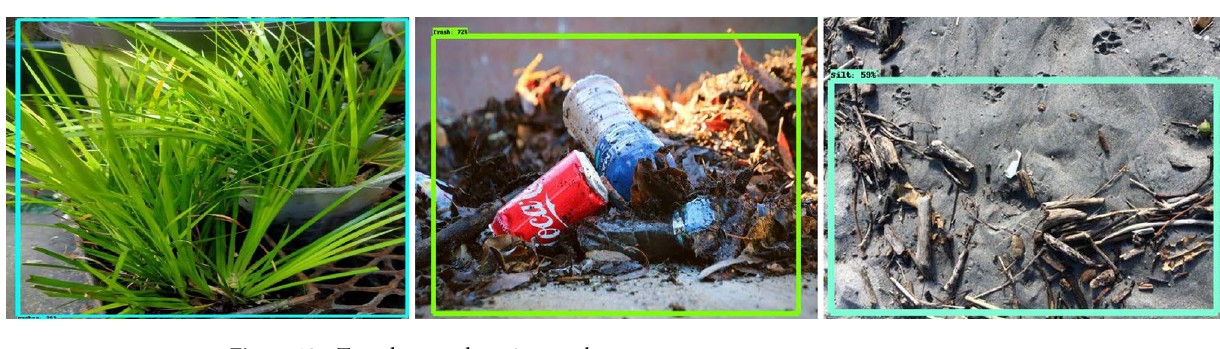
Figure 10. Taco data-set detection